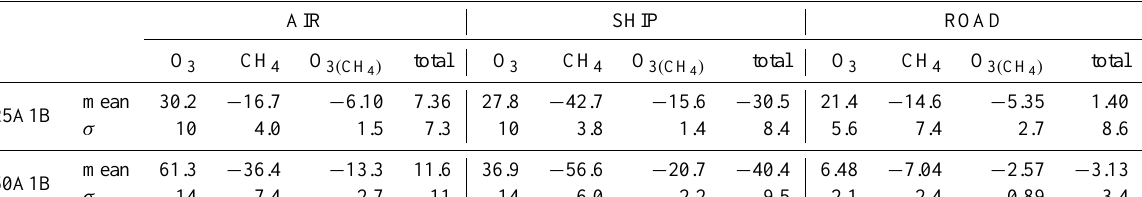
Table 4. Radiative forcings (mWm − 2 ) from changes in ozone, methane (including stratospheric water vapour), and methane-induced ozone ) for different transport sectors and years given as ensemble means and standard deviations. Note that the history of emissions has (O 3 ( CH 4 ) been taken into account (see text for details), and that the fully scaled perturbations were used.